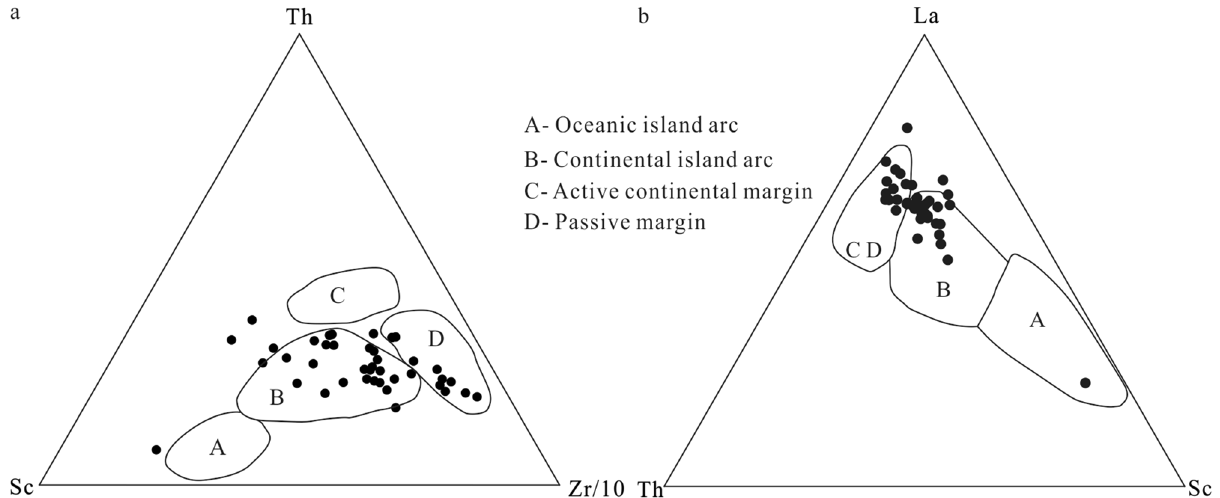
Figure 6. ( a ) Th-Sc-Zr/10 discriminatory plot (modified after Bhatia and Crook 49 ) of late Cretaceous samples from the lower Zhoutian Formation, Jitai Basin. ( b ) La-Th-Sc discriminatory plot (modified after Bhatia and Crook 49